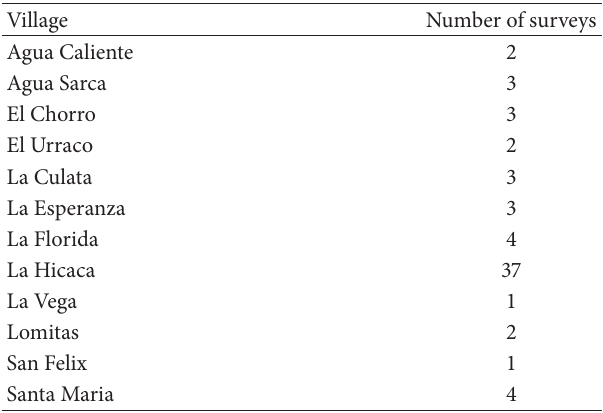
Table 1: Distribution of surveys by